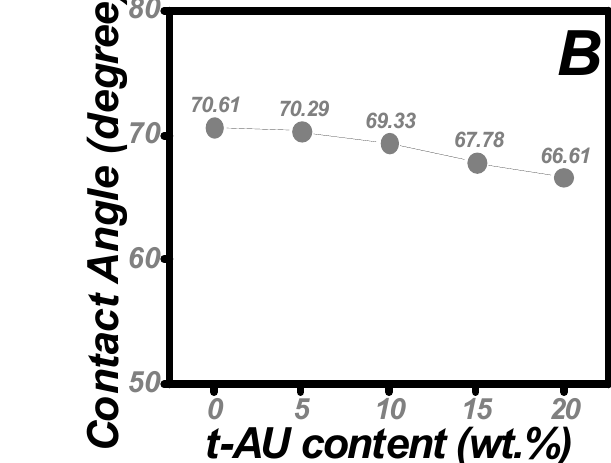
Figure 5. Transmittance of the AUP series as a function of t − AU content.